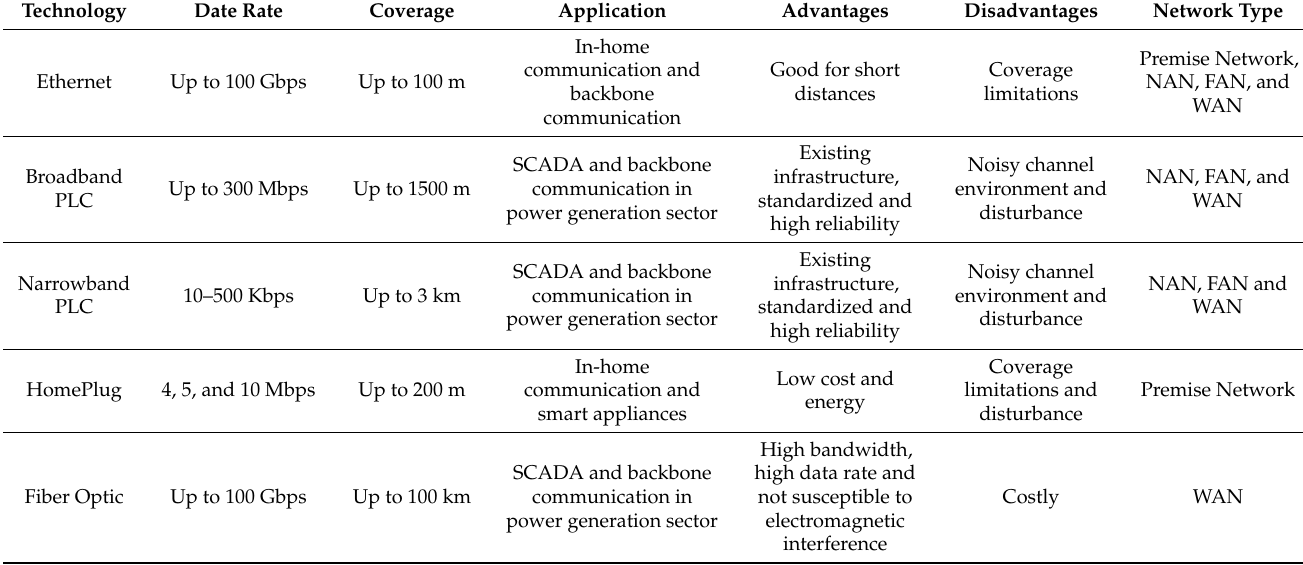
Table 2. Commonly used wireline communication technologies in smart grid systems.